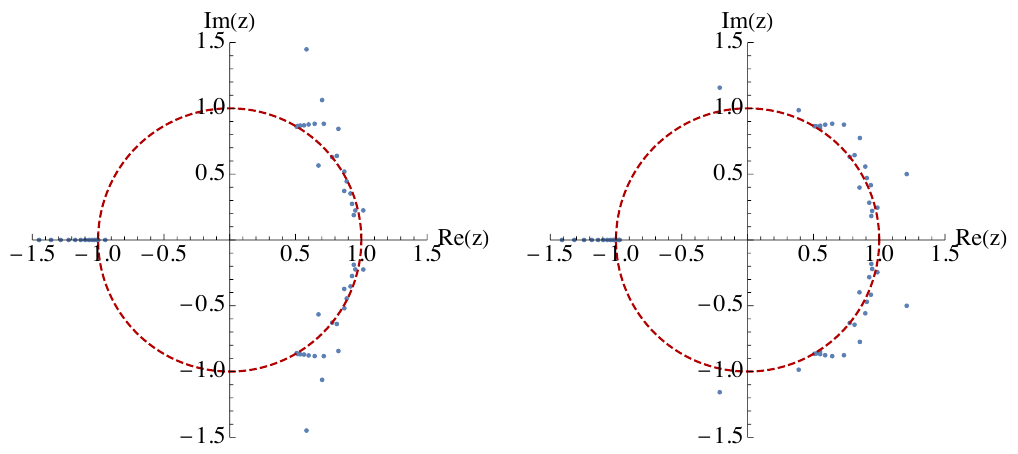
Figure 1 . Poles of the diagonal Padé approximant of highest order for ∆ 1 (left) and ∆ 2 (right). The poles are in the z variable, after the transformation